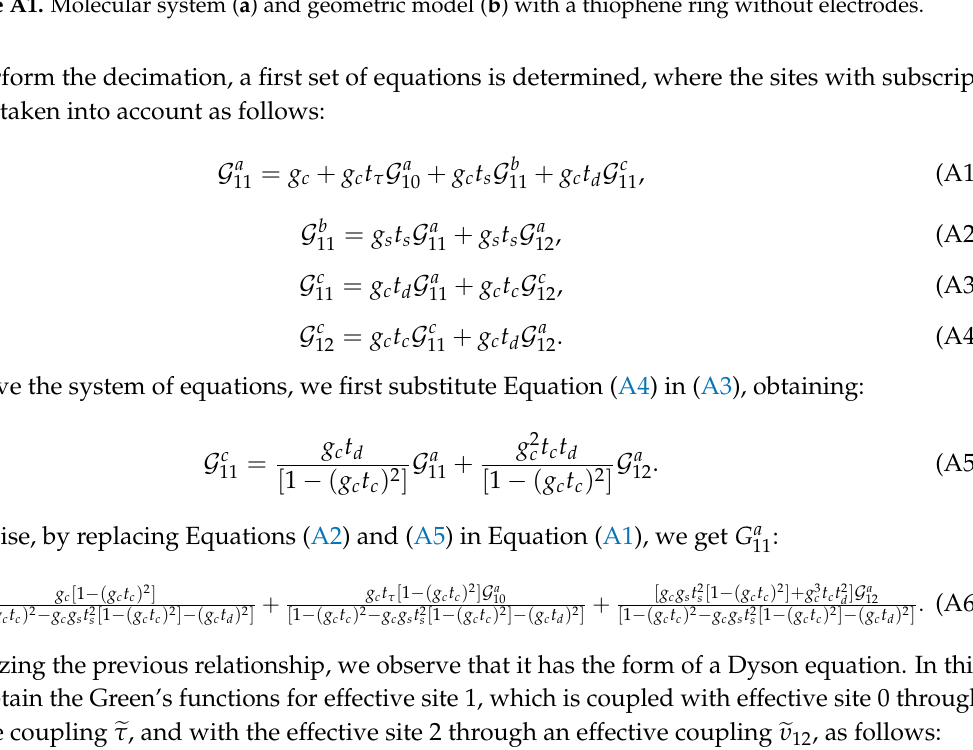
Figure A1. Molecular system ( a ) and geometric model ( b ) with a thiophene ring without